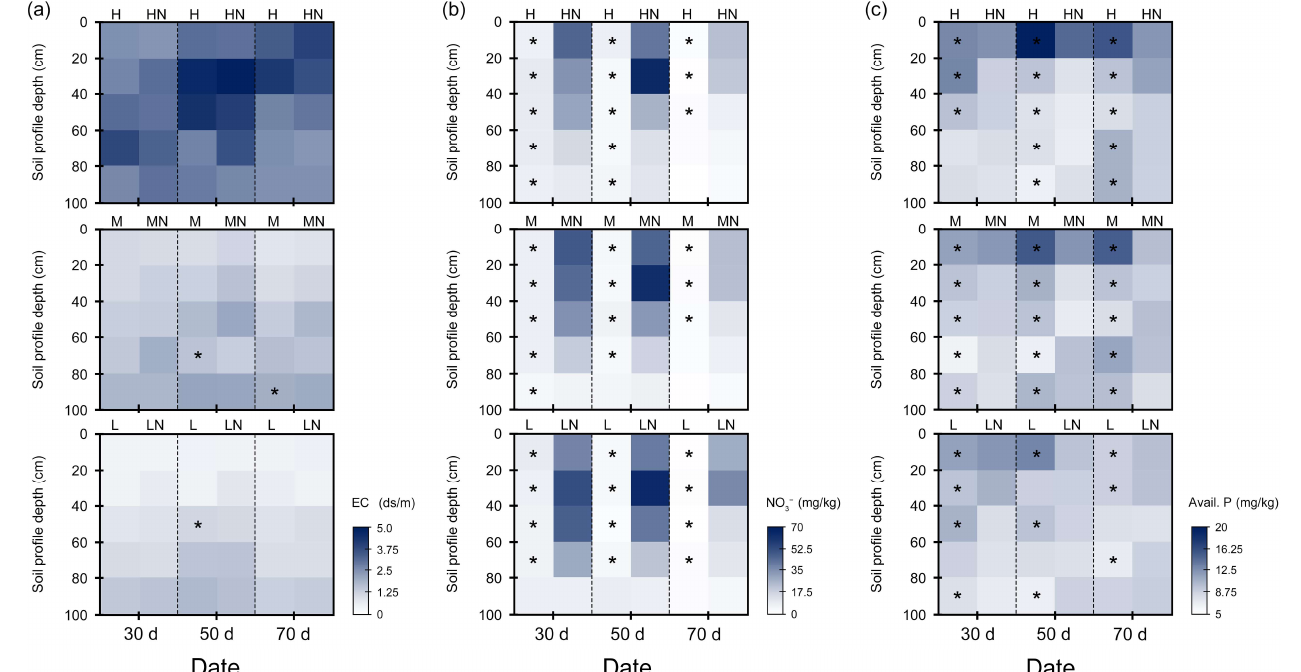
Figure 3. Soil EC ( a ), NO 3− contents ( b ), and Avail. P ( c ) in the soil profile (0–100 cm) during the experimental periods. *Indicates a significant difference between the plots without N addition and with N addition in terms of soil characteristics under the same soil salinity level in the same determination period ( p < 0.05). Table 3. Results of multiple-way ANOVA on the effects of salinity (S), N addition (N), growth stage (G), soil depth (D) and their interactions on soil salt and nutrient characteristics.